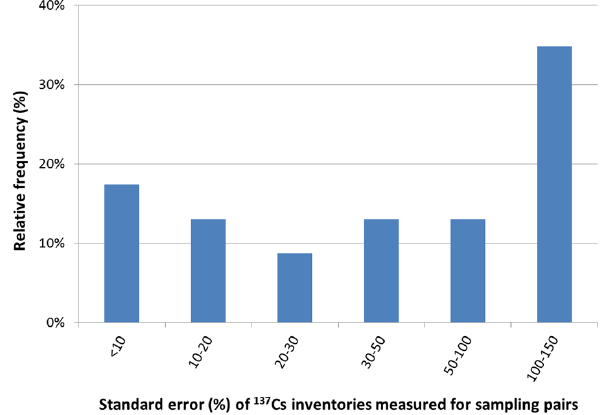
Figure 4. Relative frequency of the difference in standard error of a pair of 137 Cs inventories measured in the same topographic posi- tion.